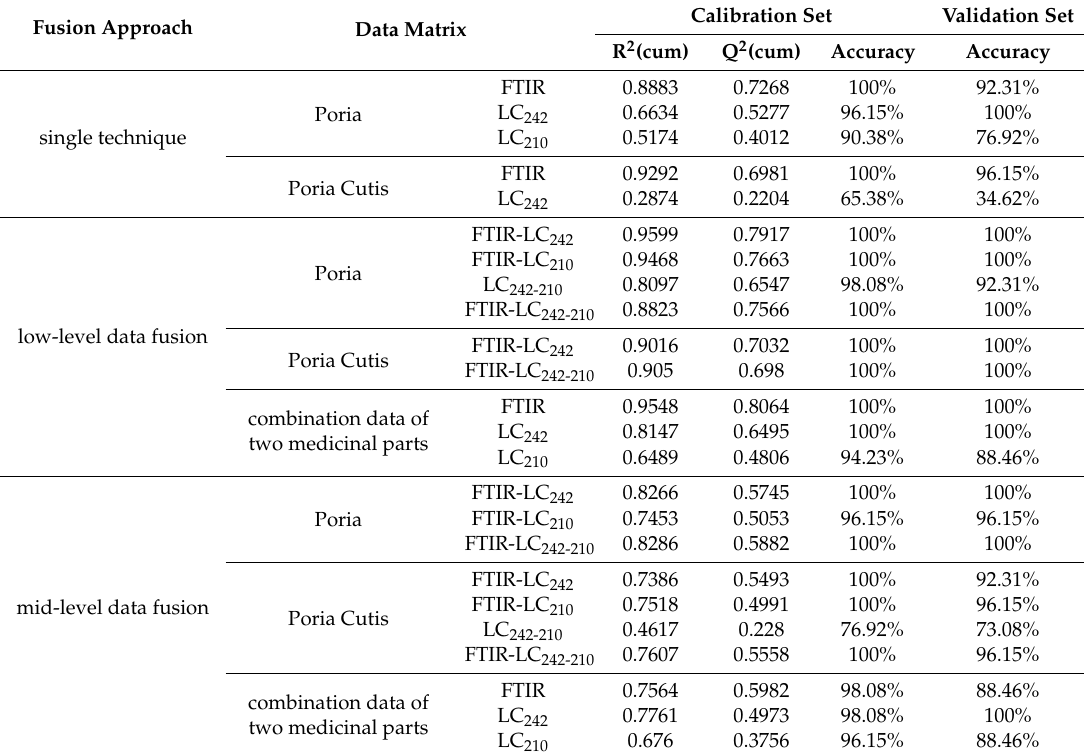
Table 1. The major parameters of PLS-DA